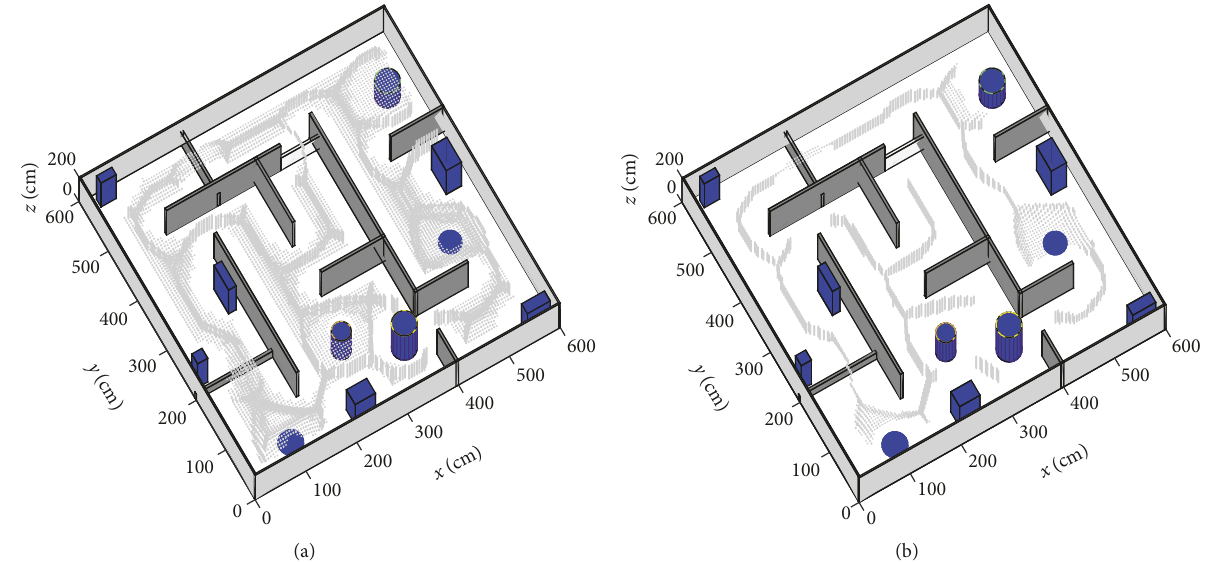
Figure 2: Two FMS of the environment based on different UAV sizes ((a) 𝛿 = 20cm, (b) 𝛿 = 40cm).